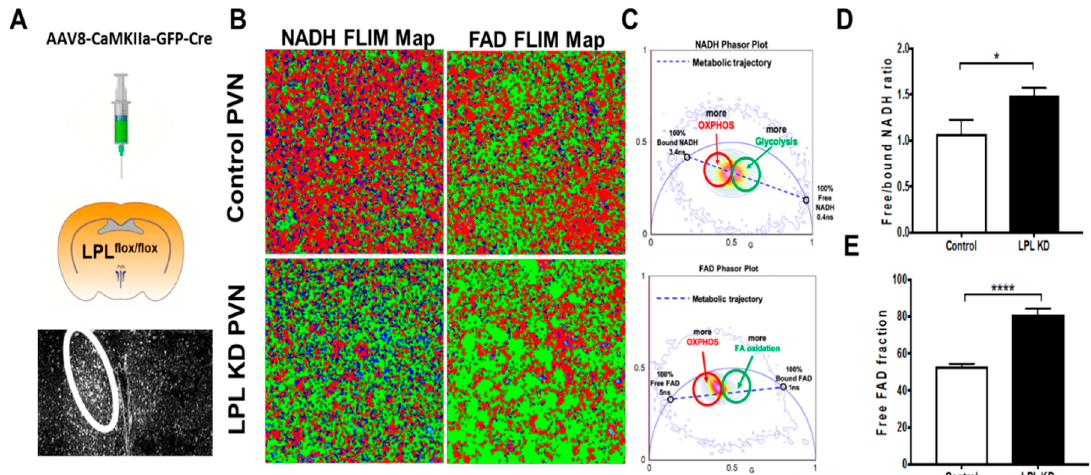
Figure 4. LPL depletion in neurons of the paraventricular nucleus of the hypothalamus (PVN) results in altered neuronal metabolism. ( A ) LPL was depleted in the PVN of LPL flox mice by the delivery of AAV8-CaMKIIa-GFP-Cre, whereas AAV8-CaMKIIa-GFP was administered to control mice. ( B ) Representative images of nicotinamide adenine dinucleotide (NADH) and flavin adenine dinucleotide (FAD) fluorescence lifetime imaging microscopy (FLIM) maps from images of the PVN in control versus LPL KD Mice. ( C ) Phasor plots showing the shift in metabolic trajectory with changing lifetime for NADH and FAD. ( D ) Increased ratio of free / bound NADH in LPL KD PVN neurons. ( E ) Increased free FAD fraction in LPL KD PVN neurons. ( * = p < 0.05 vs WT, **** = p < 0.0001 vs. WT).